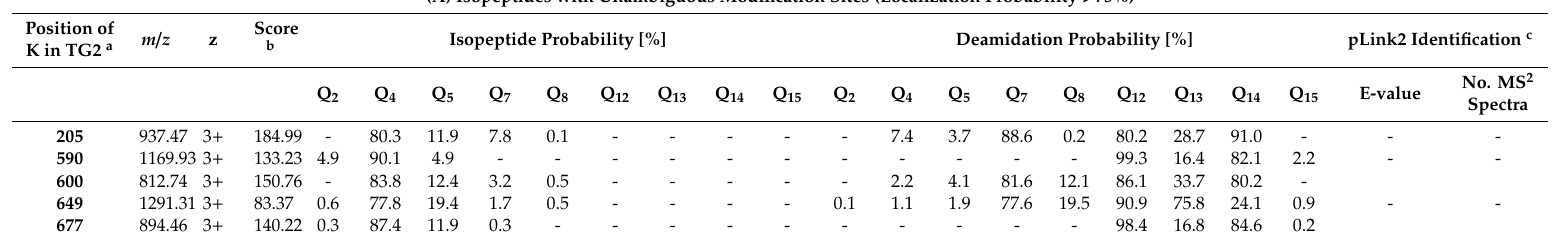
Table 5. Glutamine binding and deamidation sites in P3 (LQ 2 PQ 4 Q 5 PQ 7 Q 8 SFPQ 12 Q 13 Q 14 Q 15 PL) involved in the formation of 29 isopeptides with di ff erent lysine residues of TG2. Modified sites identified with pLink2 are given in